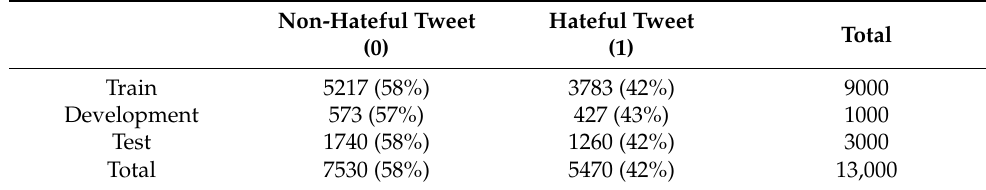
Table 2. HatEval dataset distribution of Non-hateful and Hateful tweets.